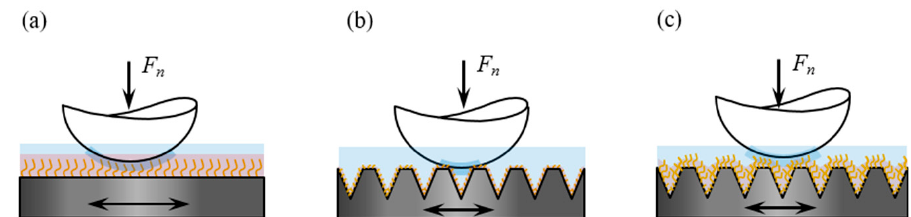
Figure 12. Schematics of the contact mechanics for ( a ) polymer brushes grafted on a flat silicon textured surface, ( b ) thin polymer brushes on a textured surface, and ( c ) thicker polymer brushes on a textured surface.